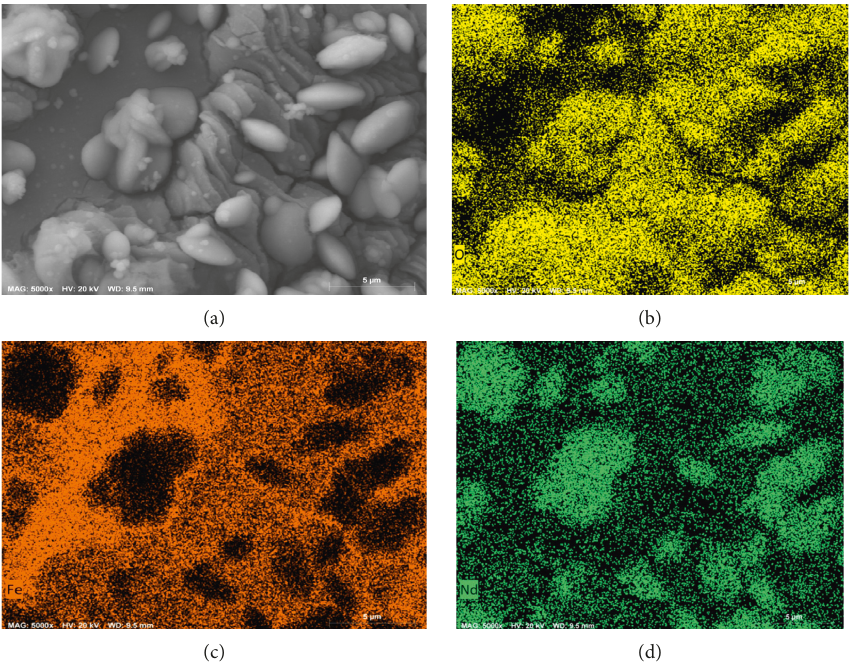
Figure 12: View to higher magnification to the corrosion product layer developed on the steel surface and mapping of elements.